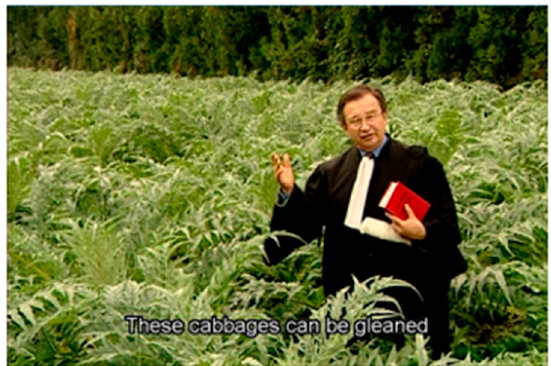
Figure 14. Magistrate explaining the 1554 law that establishes gleaning as a civil right.